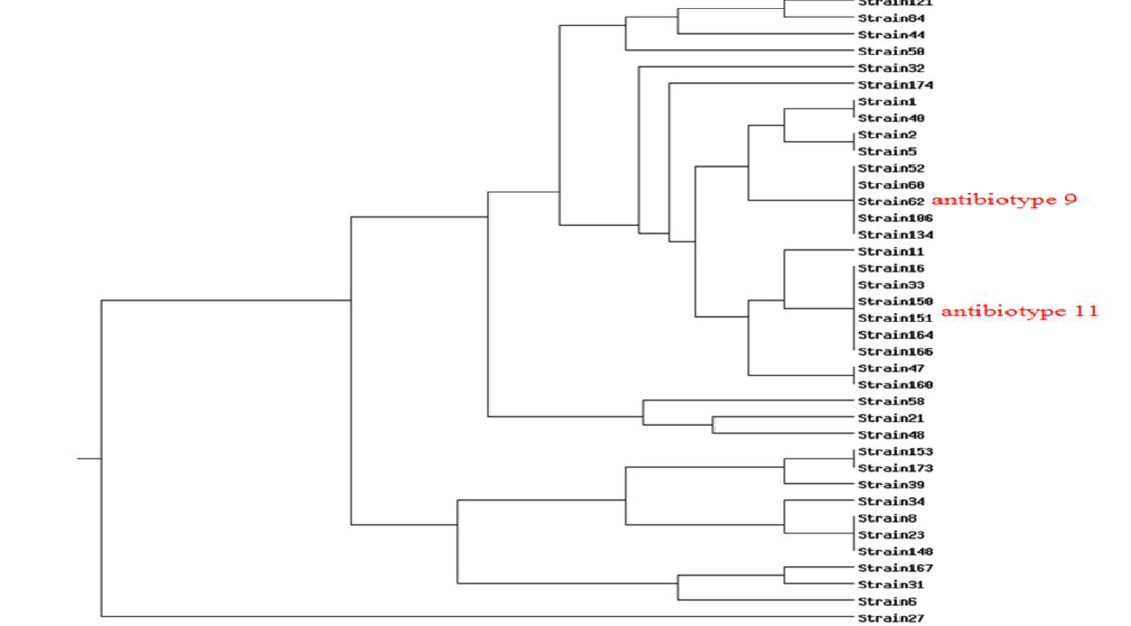
Figure 3. Dendrogram of susceptibility reports of MDR Bacillus isolates. Cluster analysis was generated with the Dice similarity coefficient and UPGAMA clustering